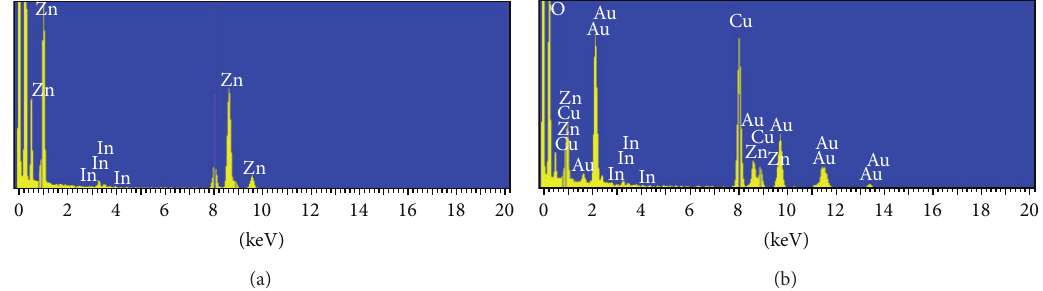
Figure 4: The representative EDS spectra results of (a) the stem and (b) tip part from ZnO:In NWs.